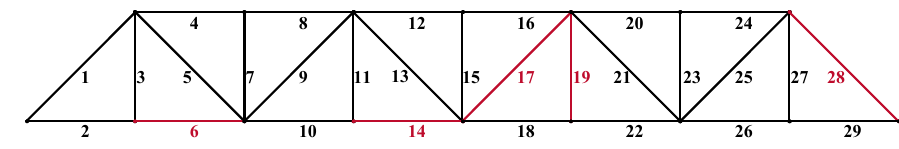
Figure 2. Sketch of the truss structure.